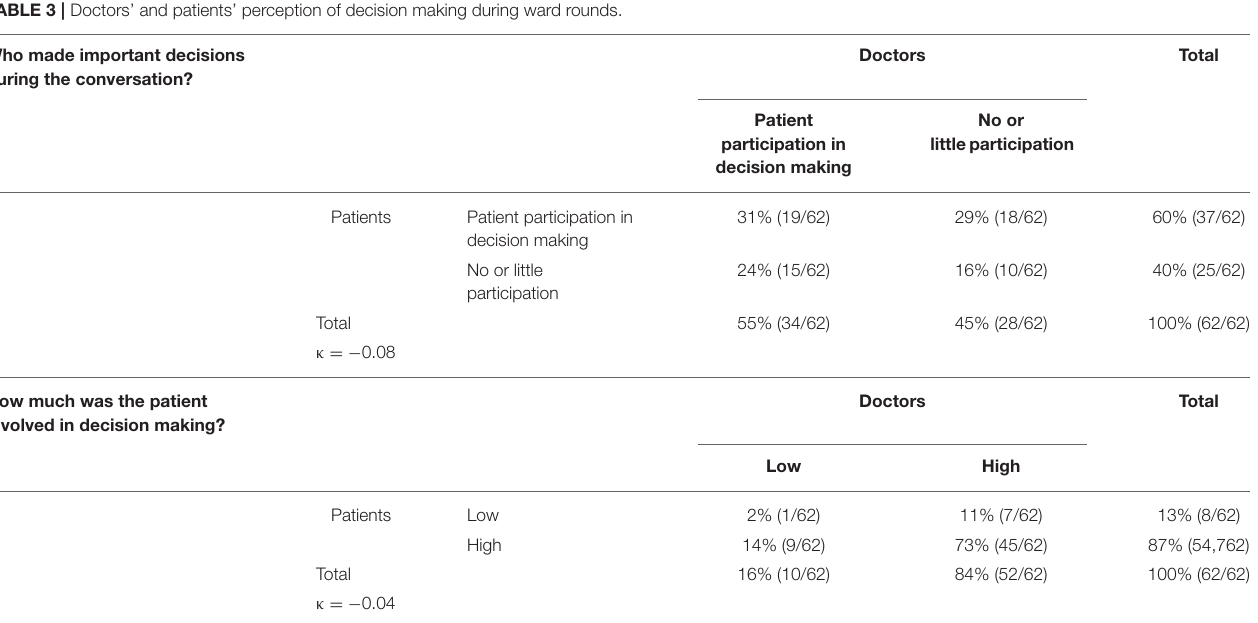
TABLE 3 | Doctors’ and patients’ perception of decision making during ward rounds. Who made important decisions during the